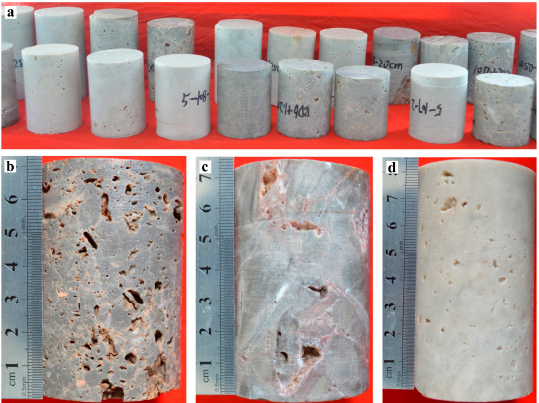
Figure 4. Image of the vuggy dolostones with millimeter-to-centimeter-scale vugs in the Xiaoerbulake Formation from the Shihuiyao section. ( a ) Image of cylinders of vuggy dolostones. ( b ) Image of sample SHY002, flat vugs are developed with a diameter of 2–6 mm. ( c ) Image of sample SHY007, the sample develops vugs and fissures and the vugs are half ‐ filled by secondary carbonates. ( d ) Image of sample SHY016, flat vugs are developed and the distribution of vugs is scattered.